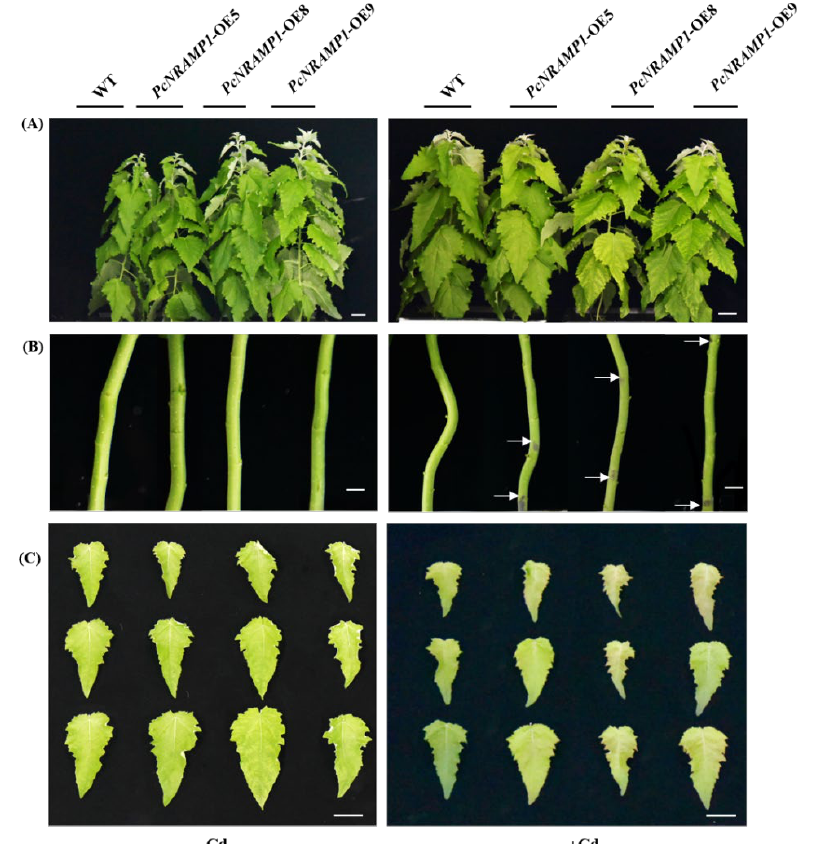
Figure 5. Growth performance of WT and transgenic lines in response to Cd stress. ( A ) PcNRAMP1 - OE5, PcNRAMP1 -OE8, PcNRAMP1 -OE9 of P . × canescens treated with either 0 ( − Cd) or 100 (+Cd) μM CdCl 2 for 2 weeks. ( B , C ) The phenotypes of the stems and the leaves (LPI = 7–9) of WT and transgenic lines demonstrating Cd toxicity. The arrows in panel B point to black spots. The bars in panels ( A – C ) indicate 5, 1 and 4 cm, respectively.